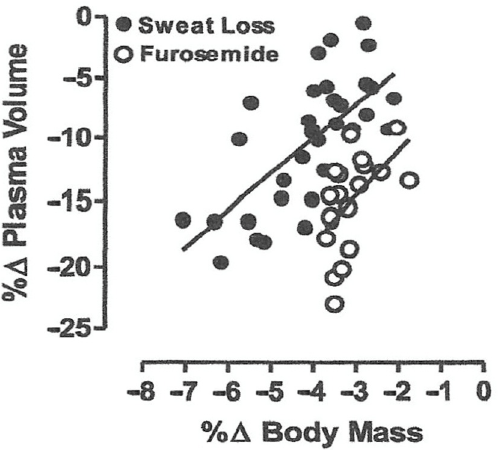
Figure 2. Linear regression of plasma volume loss (hypovolemia) and body water deficit (percent change in body mass) relationship for hypertonic (sweat loss) and isotonic (Furosimide diuretic) dehydration [16].